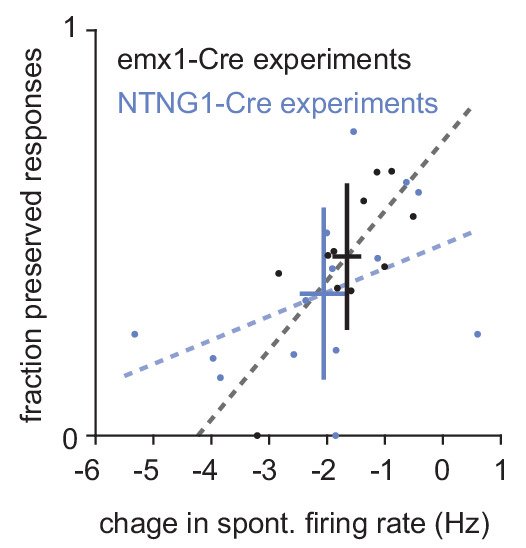
Across-experiment variability in response preservation depends on preserved spontaneous activity.Fraction of significant awake PCx cell-odor pair responses that are preserved under anesthesia vs. mean change in spontaneous firing rate in Emx1-cre recordings (black, n = 11 experiments) and NTNG1-cre recordings (blue n = 14 experiments). Dashed lines are linear fits. Solid lines are mean ± s.e.m. All recorded PCx cells are considered in this analysis, rather than dividing SL and PYR responses. Spontaneous rates were more strongly affected by anesthesia in some NTNG1 experiments, accompanied by a lower rate of response preservation.